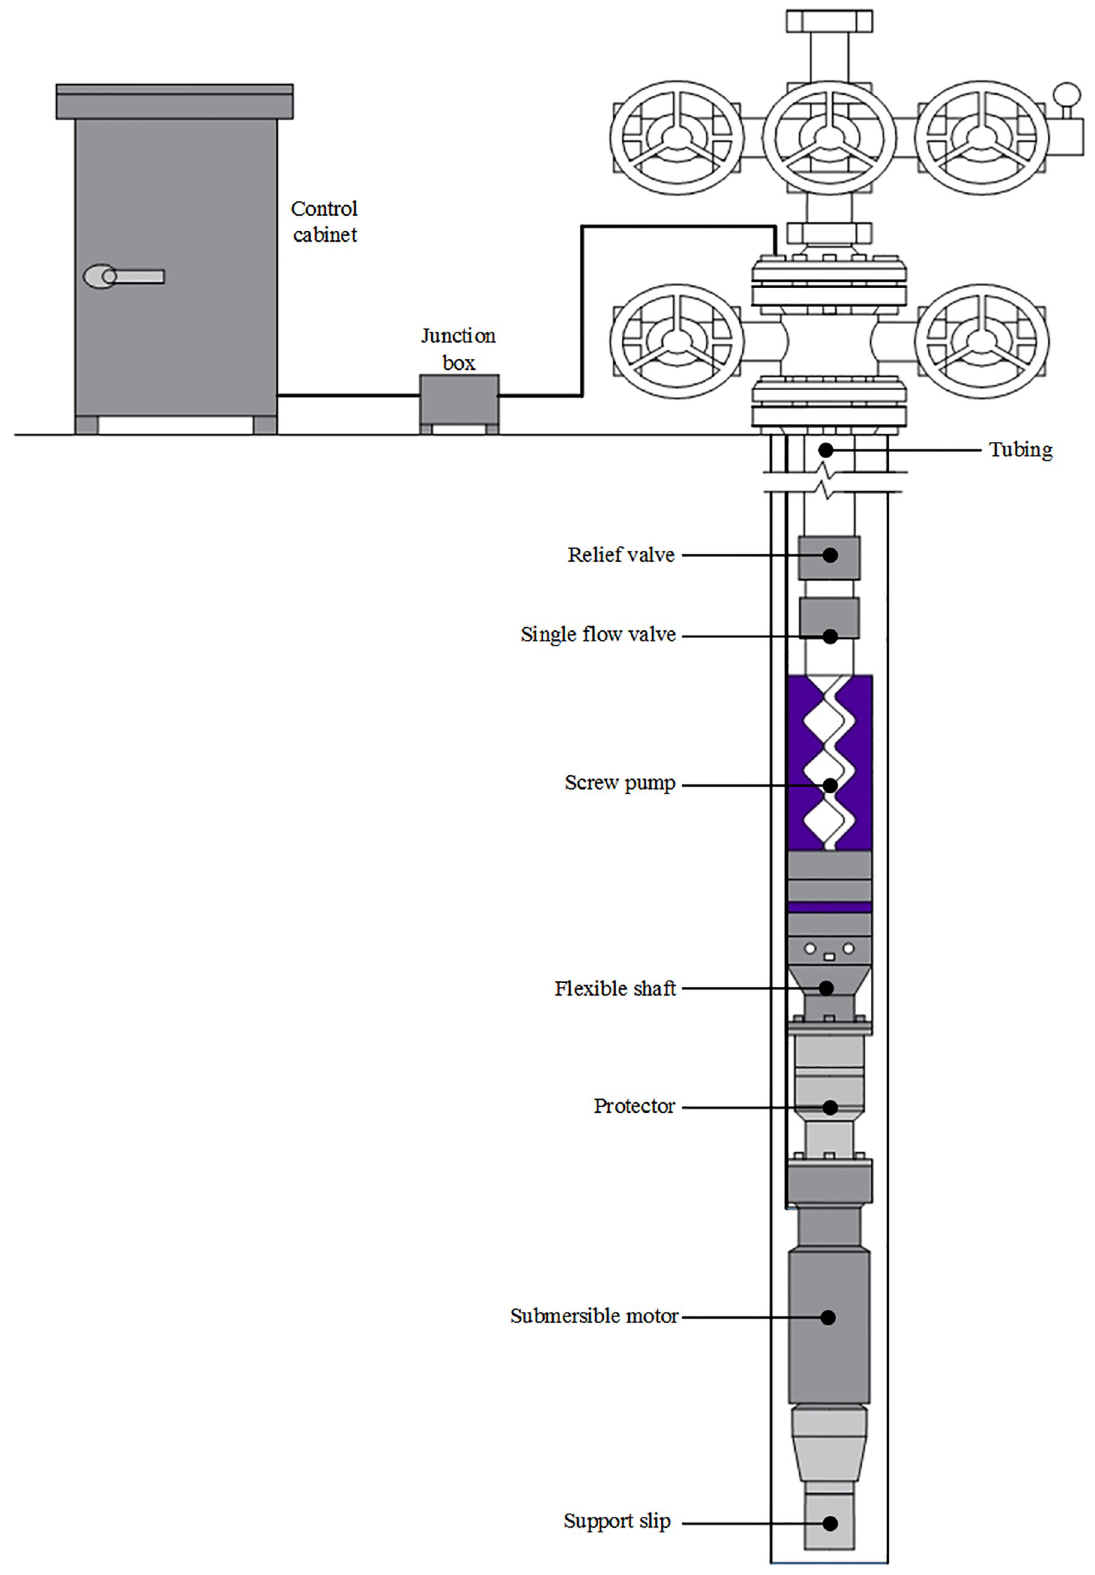
Fig 1. Schematic diagram of production system of submersible screw pump. https://doi.org/10.1371/journal.pone.0242458.g001 PLOS ONE | https://doi.org/10.1371/journal.pone.0242458 November16,